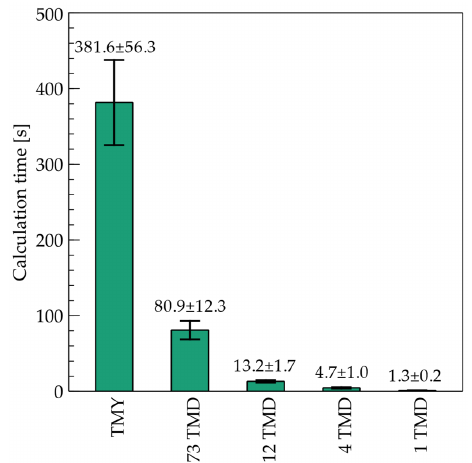
Figure 5. Computational time (CT) for different weather representation (in a Ryzen 5 2400G@3.6GHz).